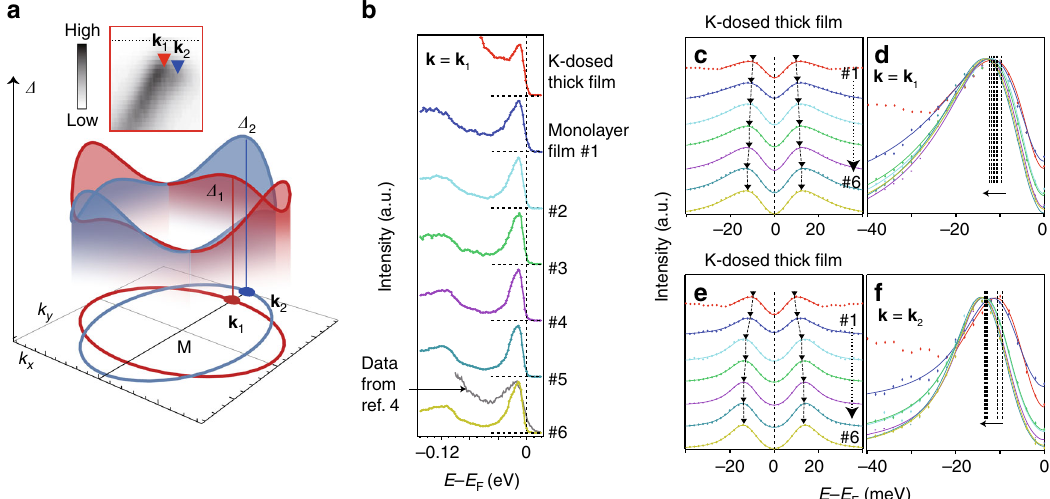
Fig. 3 Superconducting gap variation. a Illustration of the electron pockets and the anisotropic superconducting gap structure. The momentum locations of k 1 and k 2 and the superconducting gap Δ 1 at k 1 and Δ 2 at k 2 are also illustrated. The inset is a zoomed-in spectrum of the red square part of sample #6 as shown in Fig. 2b, which indicates the two different gap sizes at the two normal state Fermi momenta k 1 and k 2 . b EDCs of different samples at the Fermi momentum k 1 compared with that of the sample with T c = 60 ± 5 K in ref. 4 (grey curve). Temperature-dependent studies show that the gap of FeSe/ ST 16 O with Δ 1 = 12.1 meV closes at 64 ± 4 K (Supplementary Figure 10b, d). c Symmetrized EDCs at k 1 of different samples (dots) and the fi tting results to a superconducting spectral function (solid lines, see Supplementary Figure 8 and Methods). d Expanded view of fi tted curves from panel c overlaid to show the gap variation more clearly. e , f Same as c and d but for EDCs at k 2 and gap Δ 2 . All data were measured at 6